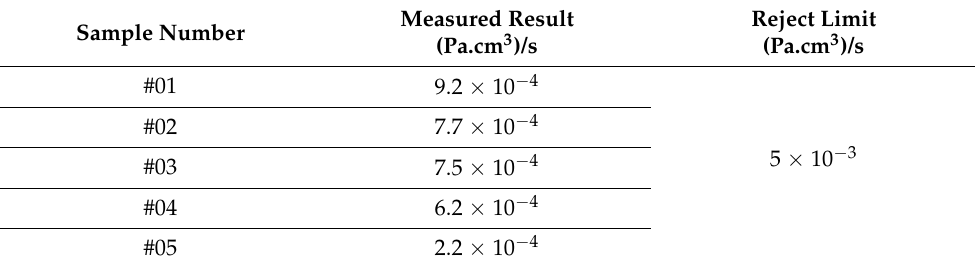
Table 3. Fine helium leak rate